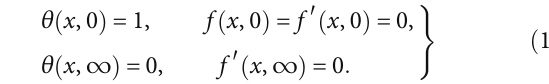
Table 1: Comparison of the present numerical results of skin friction coe ffi cient, f ″ ð x , 0 Þ , and the rate of heat transfer, - θ ′ ð x , 0 Þ , with Hossain et al. [20] for the variation of the Prandtl